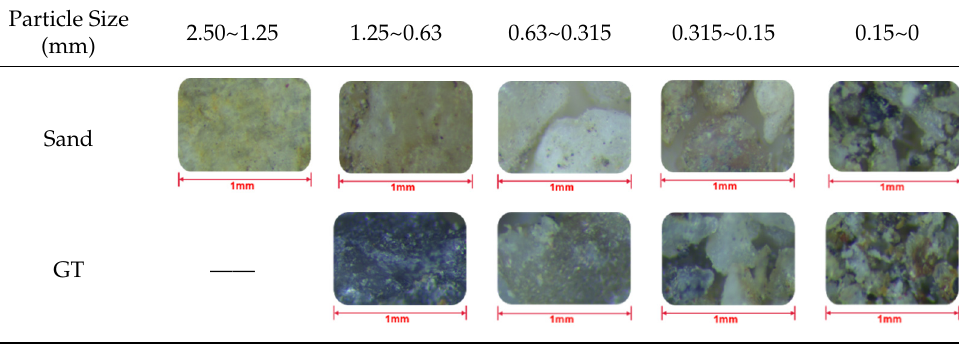
Table 4. Microscopic pictures of sand and GT with different particle sizes.